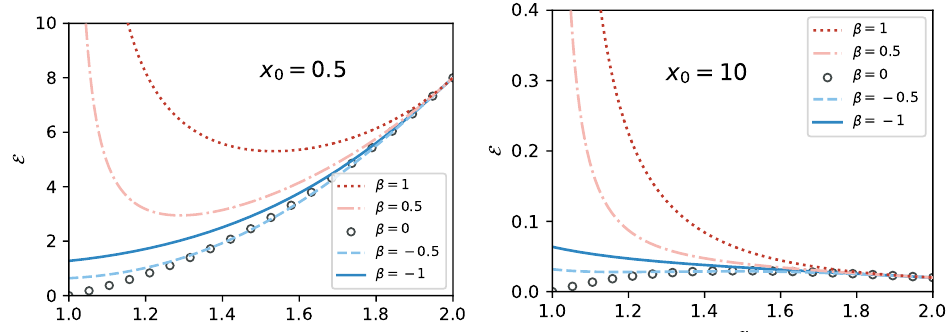
Figure 6. Search efficiency E as function of the stable index α for different values of the skewness parameter β with K α = 1.